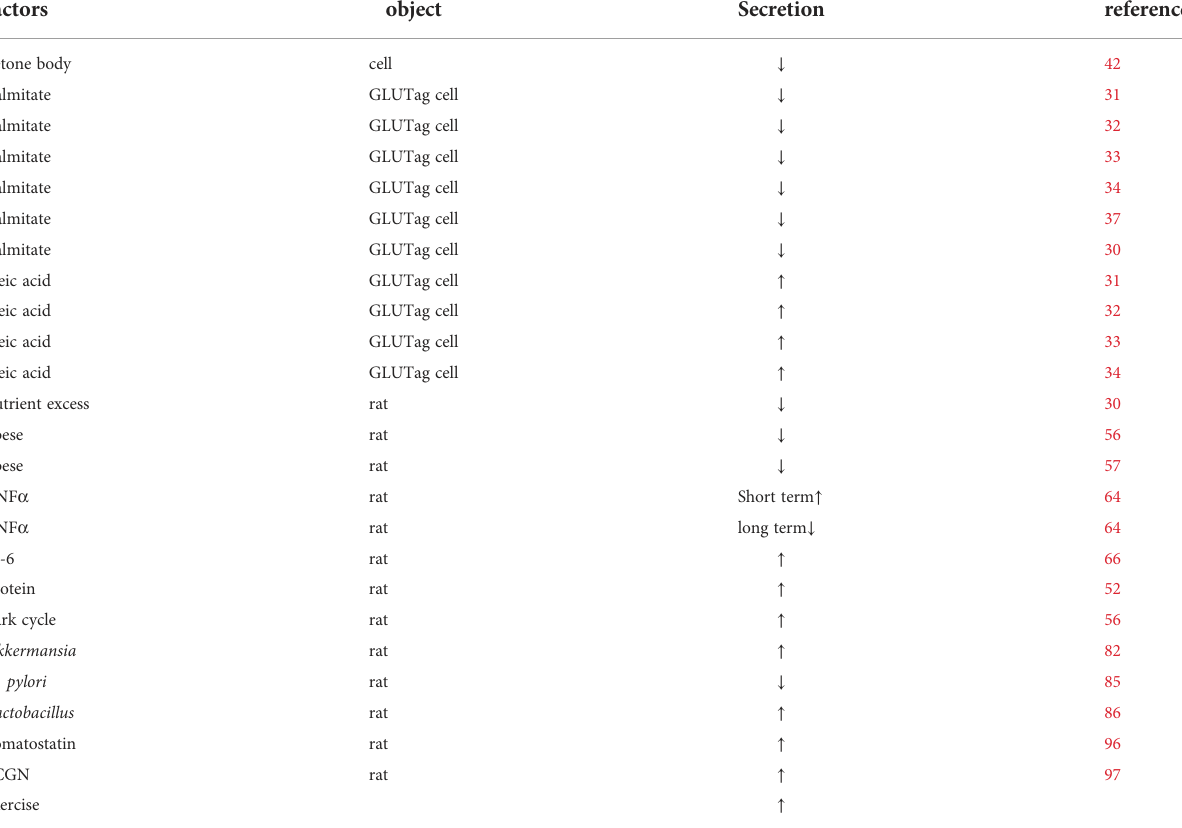
TABLE 2 Basic studies affecting the secretion of